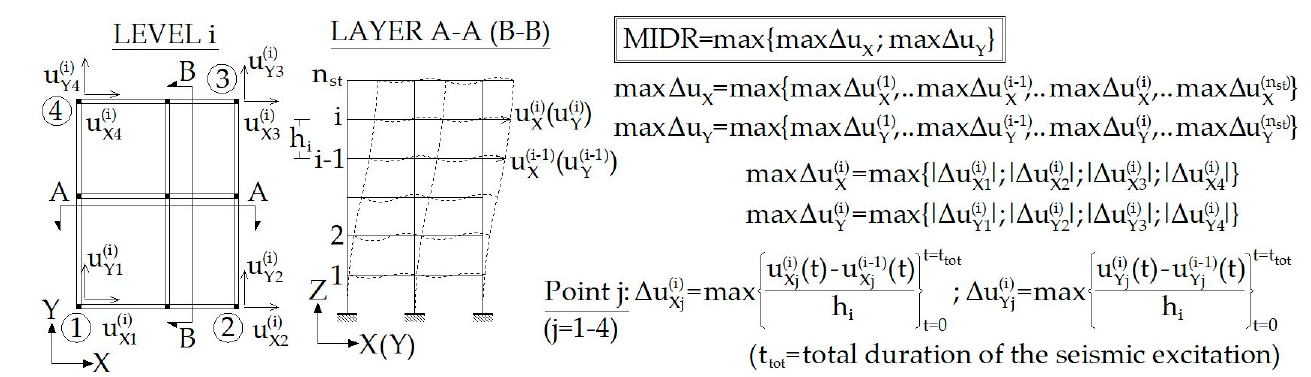
Figure A4. Calculation of the MIDR value in the case of an n-story building with arbitrary plan view.